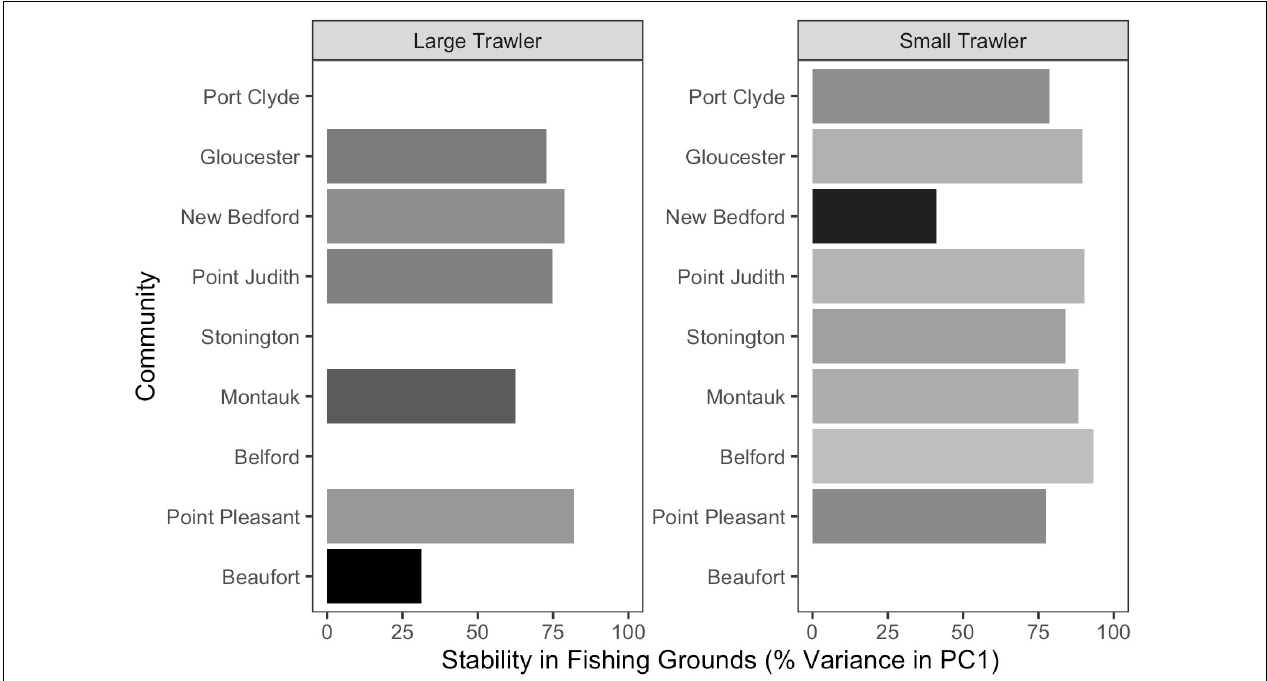
FIGURE 6 | Stability in fishing grounds measured as the percent variation explained by PC1 using a T-mode PCA on fishing locations in each year. Higher values indicate that the average fishing location across all years explained a greater fraction of the distribution of fishing effort in each